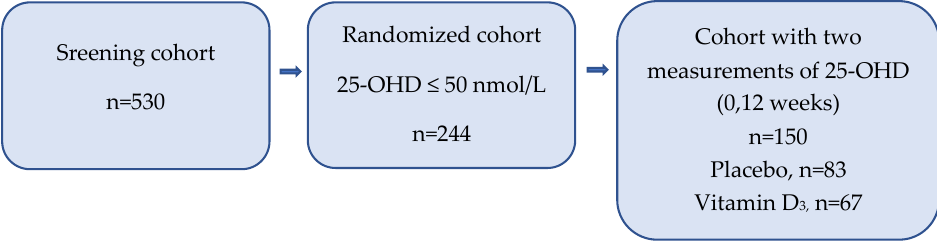
Figure 1. ‘Palliative-D’ cohorts analyzed regarding 25-OHD levels.